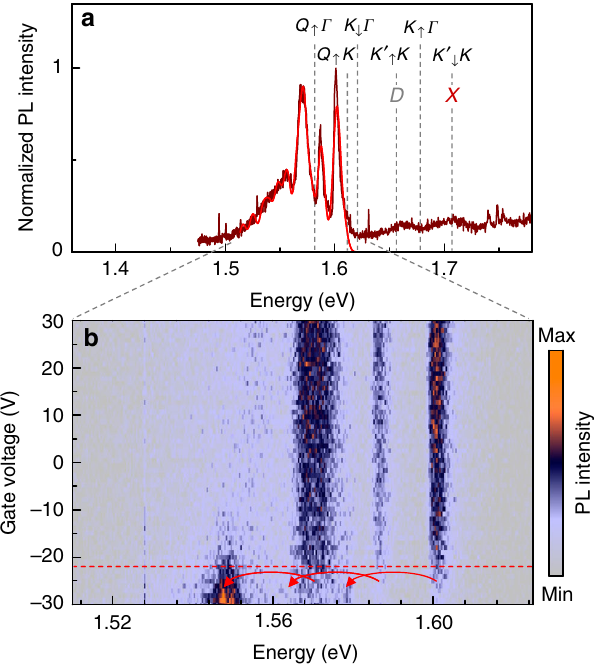
Fig. 4 Field-effect control of bilayer WSe 2 photoluminescence. a Normalized photoluminescence (brown) of a bilayer WSe 2 encapsulated in hexagonal boron nitride and tuned toward charge neutrality with positive gate voltages. Best fi t to the spectrum (red) was obtained with the same set of excitons energies as in Fig. 1c and an overall redshift of 2 meV. b Evolution of the photoluminescence with gate voltage from − 30 to 30 V. Note the cross-over to the charged regime below − 20 V signi fi ed by a simultaneous redshift of 22 meV for all peaks as indicated by the red arrows below the dashed